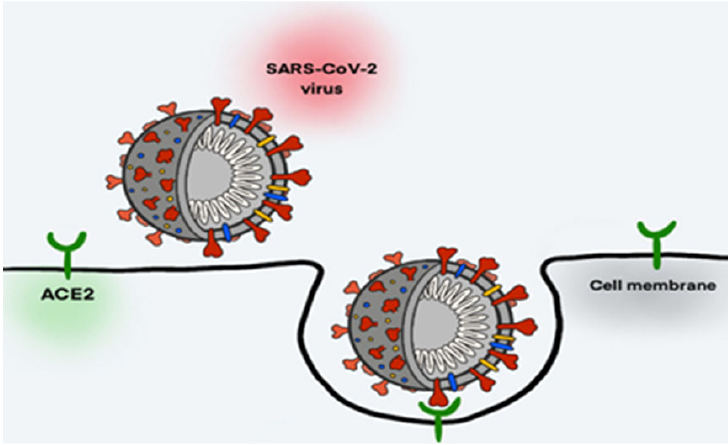
Figure 1. Diagram of SARS-CoV-2 entry into host cell. The spike glycoprotein (red), which consists of two subunits, binds to the ACE2 receptor (green) of host cells to merge the viral and cellular membranes and insert the viral genomic RNA (white) into the host cell. This induces endocytosis and the merging of the viral and cellular membranes, causing the viral genomic RNA to be inserted into the host cell, and thus, allowing the virus to replicate. The binding of SARS-CoV-2 to the ACE2 receptor causes a downregulation of this receptor, disrupting its normal function in maintaining immune homeostasis and leading to pro-inflammatory effects that can cause lung injury. The figure was reproduced from [8] (Atzrodt CL et al.,